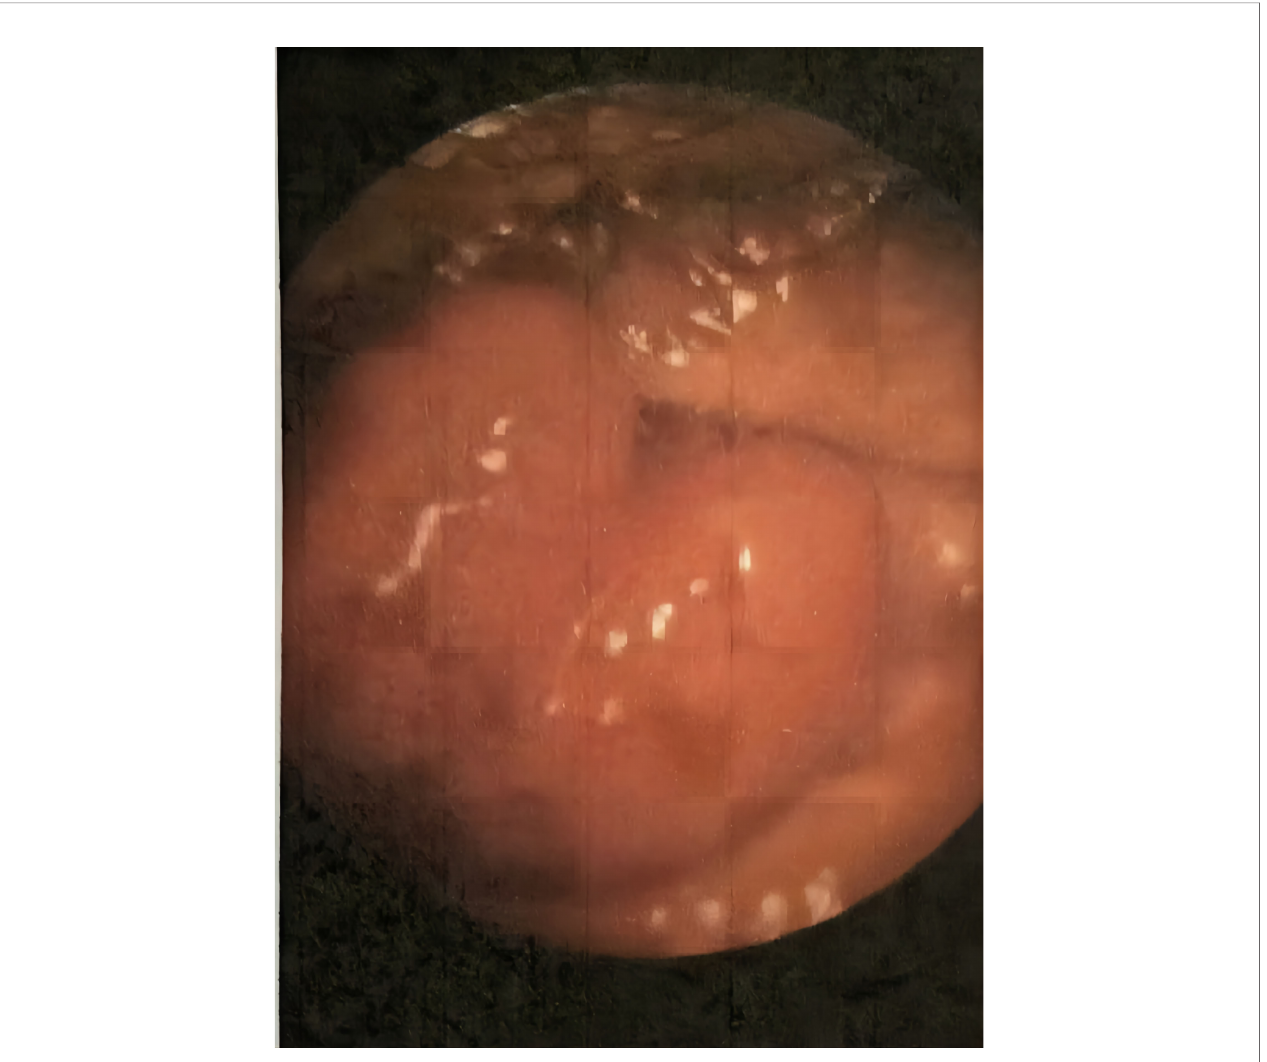
FIGURE 1 | A polypoid hyperplasia of 2 cm ✖ 1.5 cm in size was observed at 6 o'clock in the external urethral meatus, with smooth